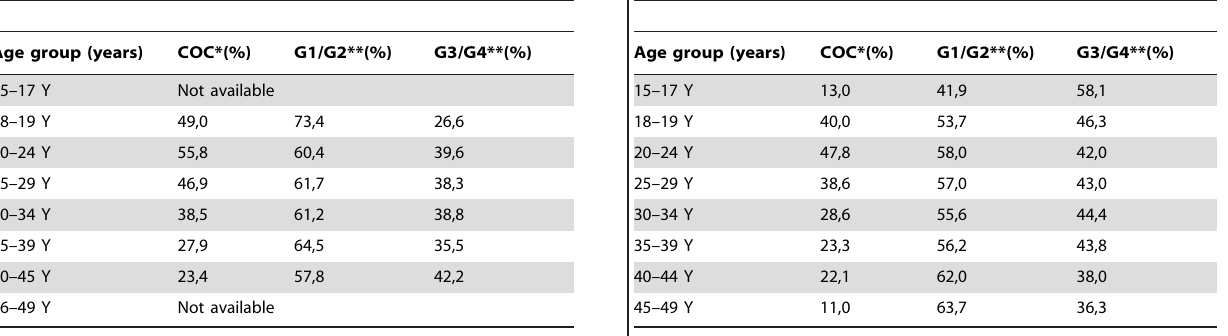
Table 3. Exposure of combined oral contraceptives, overall and by generation, in France - Results of Cocon survey, 2000.